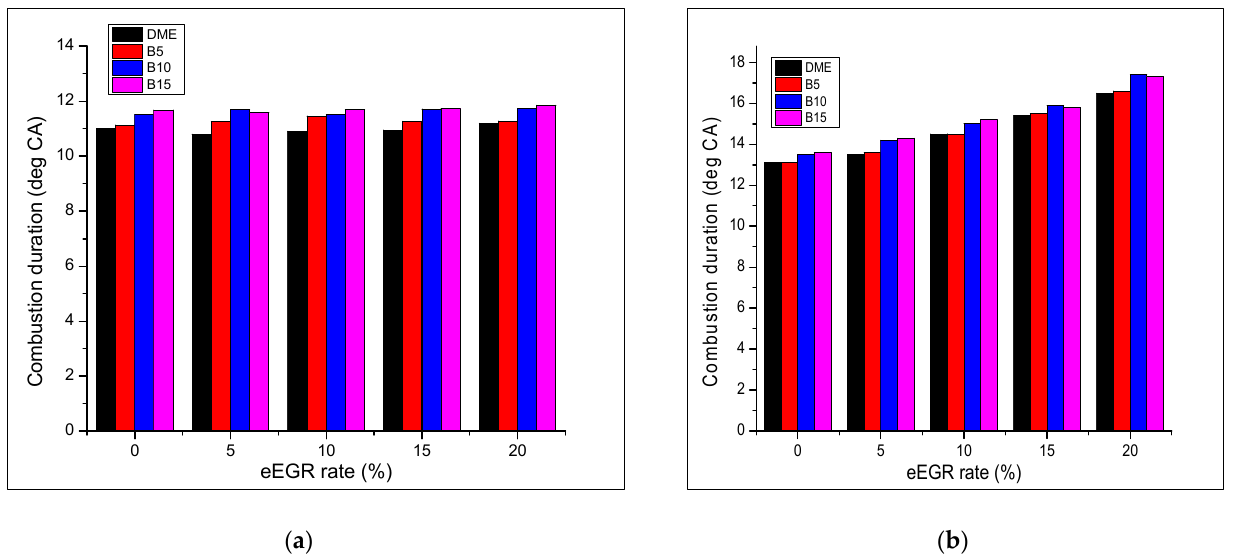
Figure 5. Effect of eEGR rate on combustion duration at: ( a ) low load (BMEP = 0.4 MPa); ( b ) high load (BMEP = 0.8 MPa).